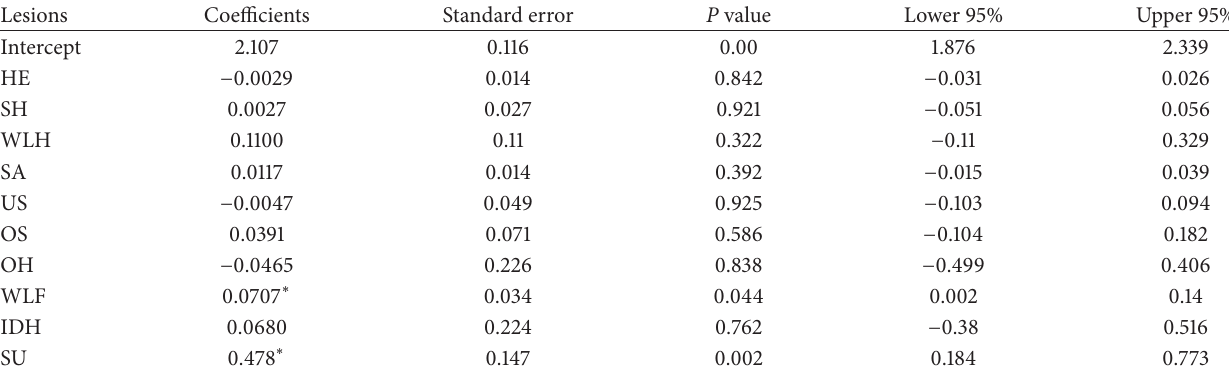
Table 1: Association between locomotion scores (2 and 3) and various lesions.